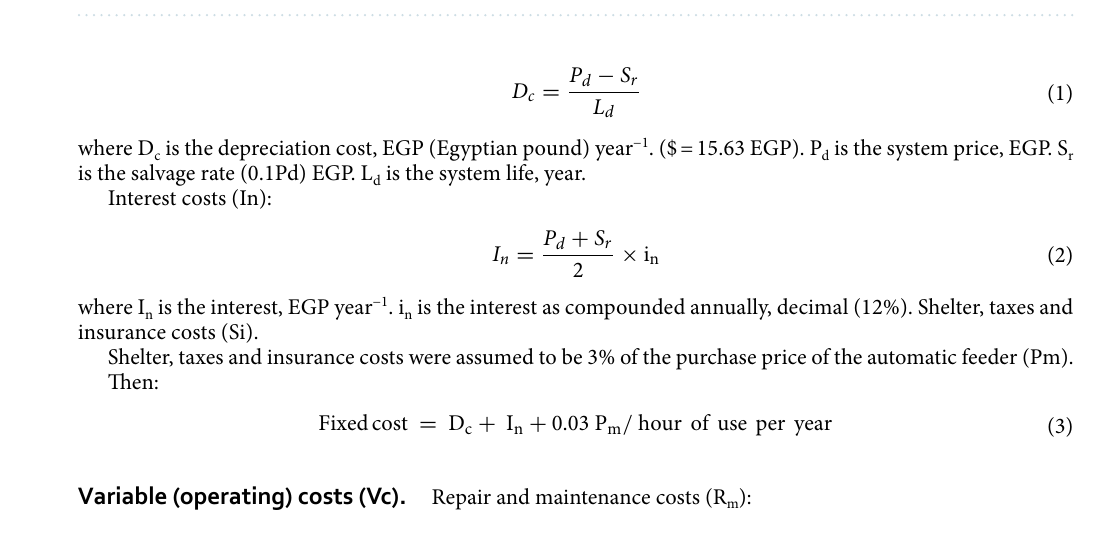
Figure 1. (a) The experimental setup. ( b) Images of